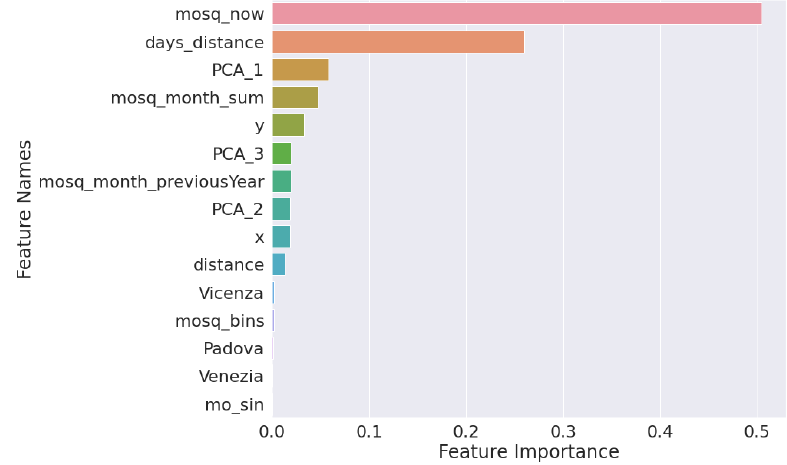
Figure 9. Feature importance of Culex Italy case without using any EO data.